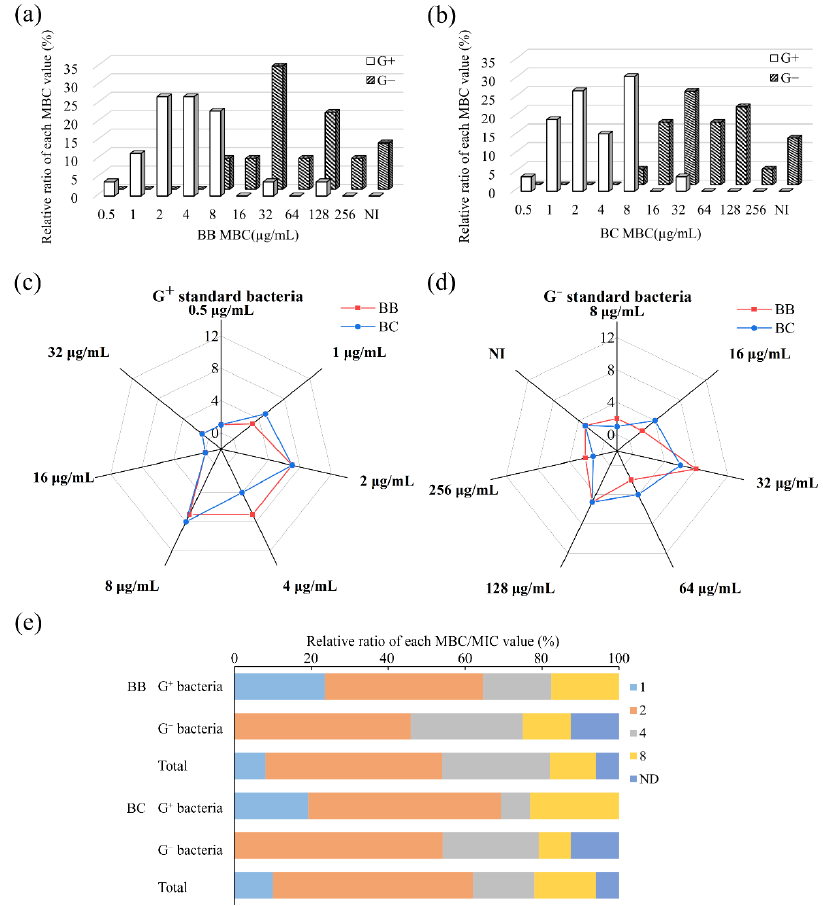
Figure 2. Bactericidal activity of brevilaterins against 50 species of standard bacteria. ( a , b ) the distribution of minimal bactericidal concentration (MBC) values of brevilaterin B (BB) and brevilaterin C (BC) against all standard bacteria; ( c , d ) comparison of MBC value distribution of brevilaterin B and brevilaterin C against Gram-positive bacteria ( c ) and Gram-negative bacteria ( d ), respectively; ( e ) the relative ratio of MBC/MIC value of brevilaterins against bacteria. ND, no value for undetected MIC and MBC. G + stands for Gram-positive. G − stands for Gram-negative, for convenience. Table 4. Summary of MIC and MBC values of brevilaterin B and C to isolated spoilage bacteria from different